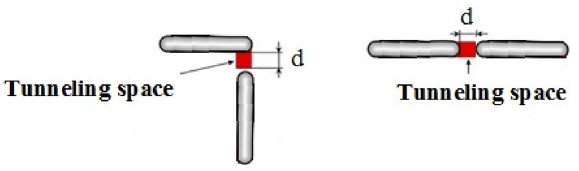
Figure 1. Two types of contact spaces in polymer graphene